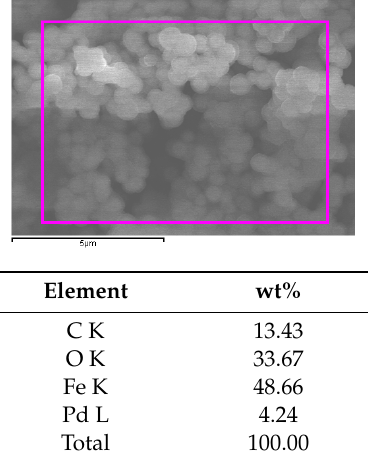
Table 1. EDS spectra of Fe 3 O 4 @PDA@Pd.